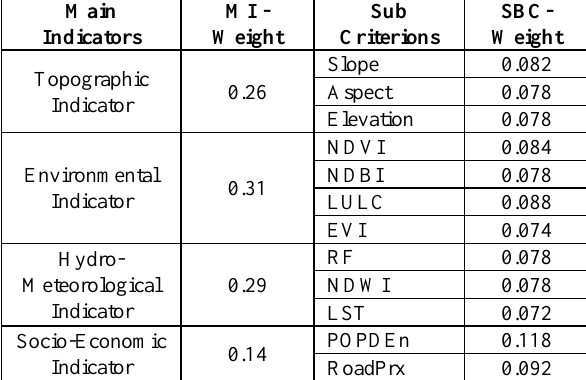
Table 2. Main indicator and sub criterions weight